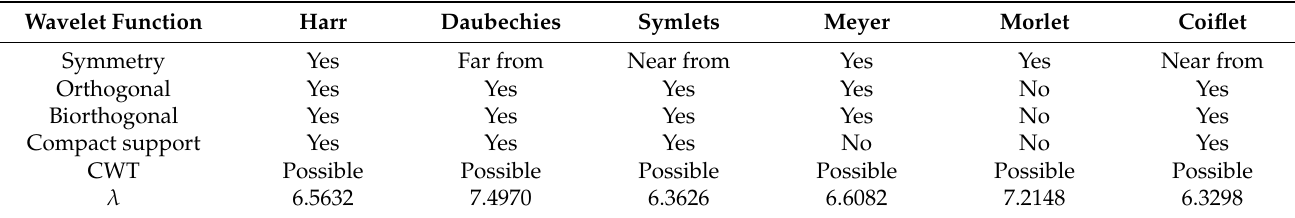
Table A1. Properties of wavelet basis